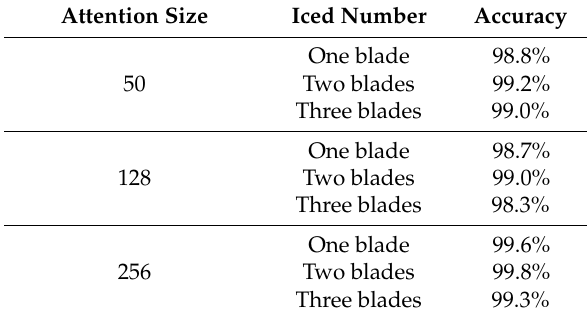
Figure 9. The accuracy curves: The red curve is the accuracy of model with 256 attention size, and the blue curve is the accuracy of LSTM without attention mechanism. Table 2. The accuracies of models with di ff erent attention